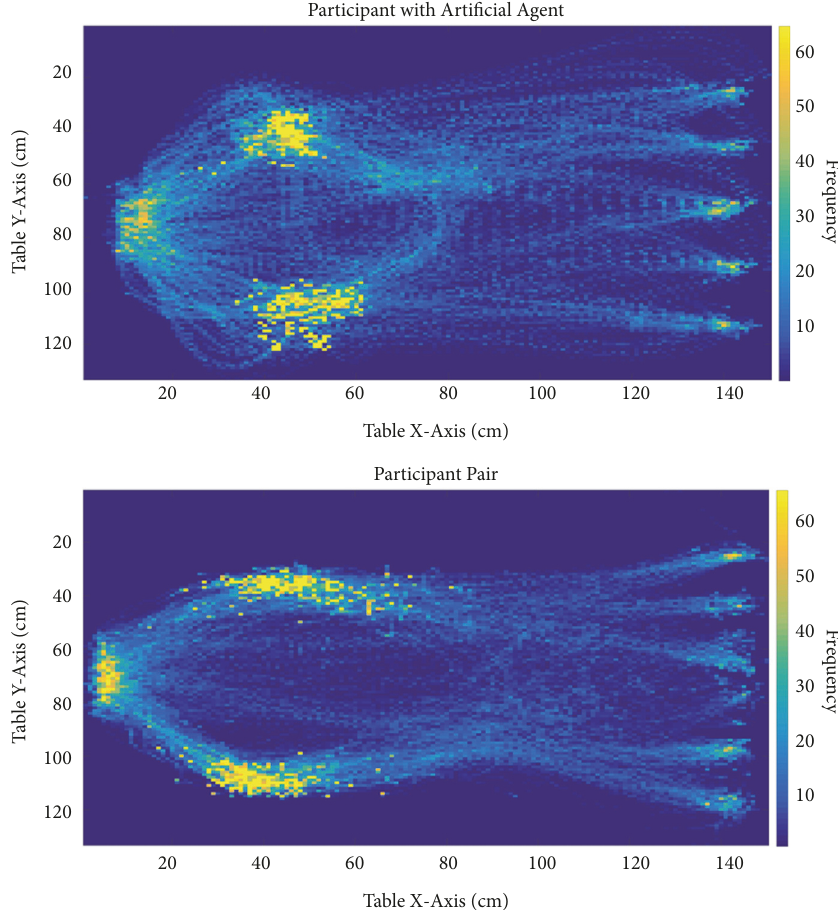
Figure 8: Example trajectory heat maps for HHI participant pair (bottom) and HAI participant with PAPA (top). Heat map colors represent frequency of hand positions at a given location in the table task space. Participants were positioned relative to the top and bottom of the figure, objects appeared on the left, and target locations were on the